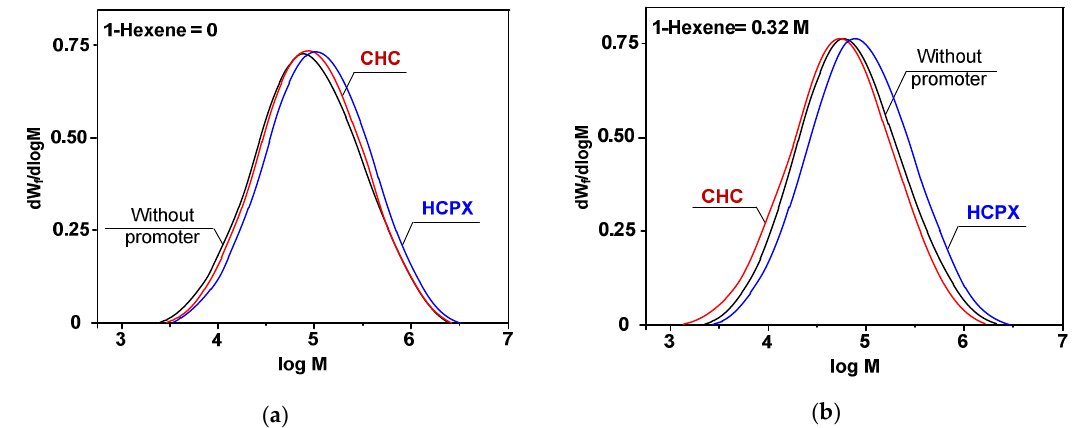
Figure 5. The shape of the MWD curves of PE samples: ( a ) produced upon ethylene homopoly- merization in the presence of CHC and HCPX; ( b ) produced upon ethylene/1-hexene (0.32 M) co- polymerization in the presence of CHC and HCPX.